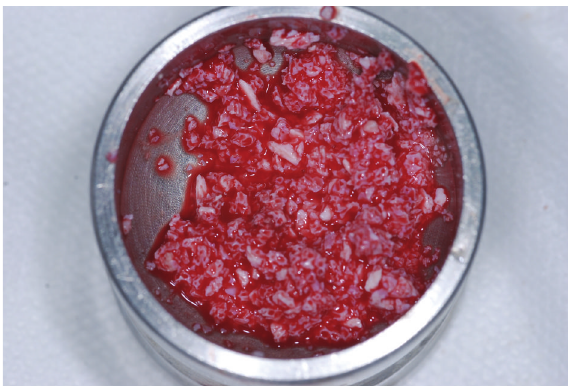
Figure 8: Dental implants (Blackfix, AS Technology, S˜ao Jos´e dos Campos, Brazil) immediately after they are